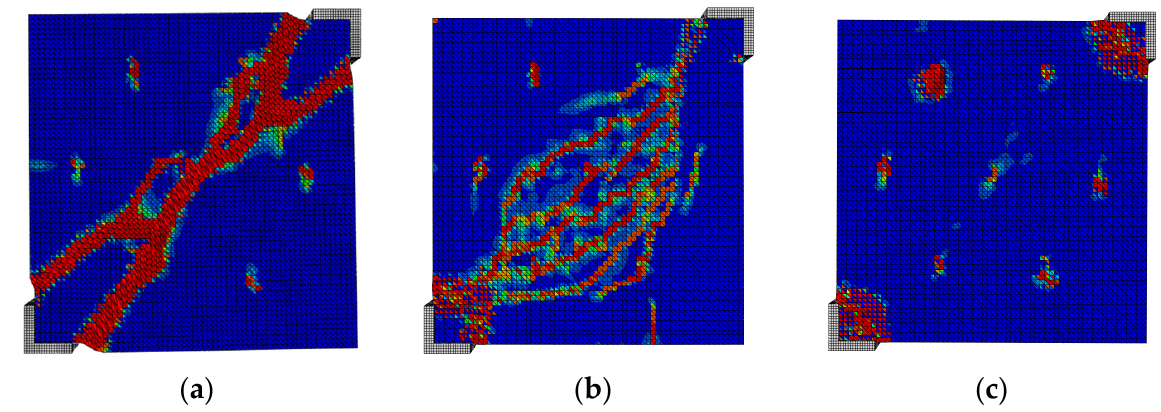
Figure 25. Damage pattern at failure for different configurations of reinforcement: ( a ) no reinforce- ment; ( b ) steel net; ( c ) fiber-reinforced plaster.